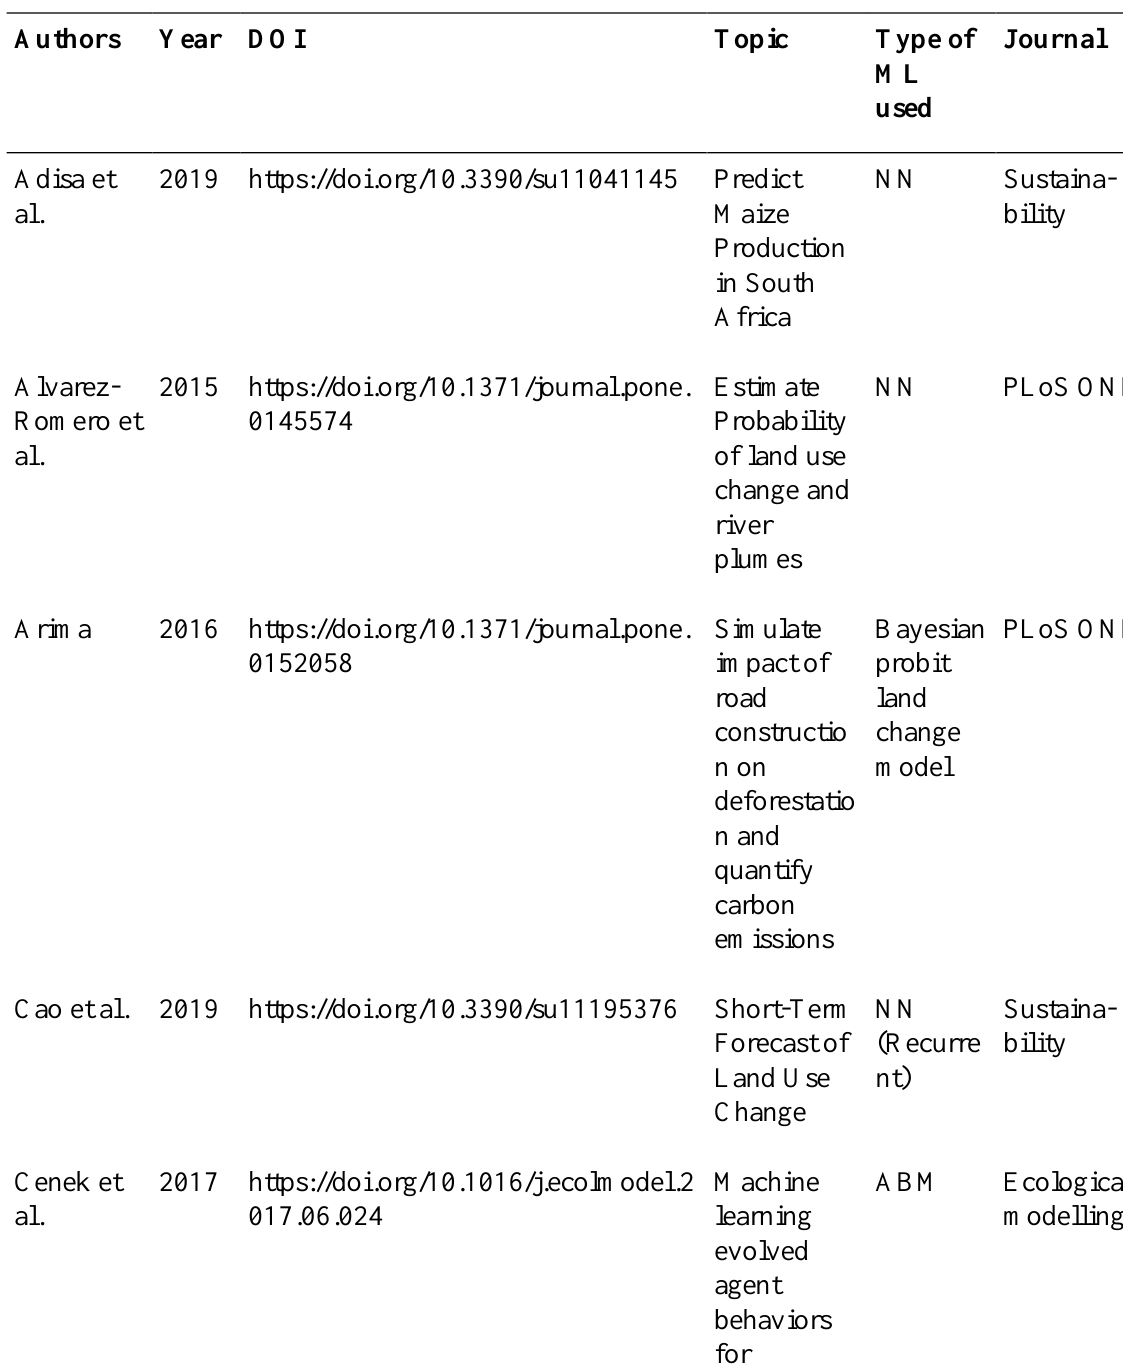
Table A2 . Overview of all articles using machine learning (ML) methods on a topic in natural resource